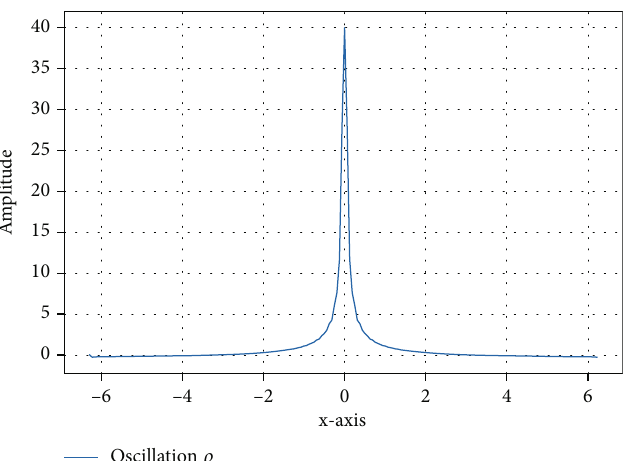
A ð n Þ sin ð n · k ′ r Þ cos ð n · k ′ c t Þ / r centred at the origin of the coordinates at time s ,0 n =1 = 1 . Oscillation ρ represents the oscillation of the 40 spherical standing waves s ,0